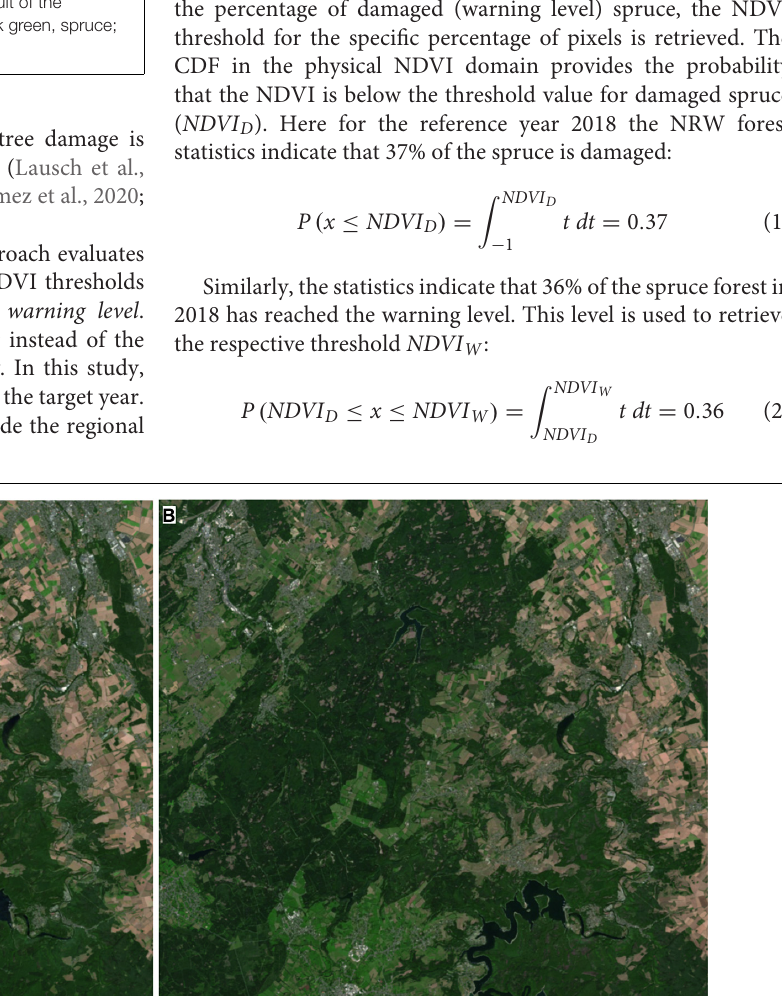
Frontiers in Forests and Global Change |